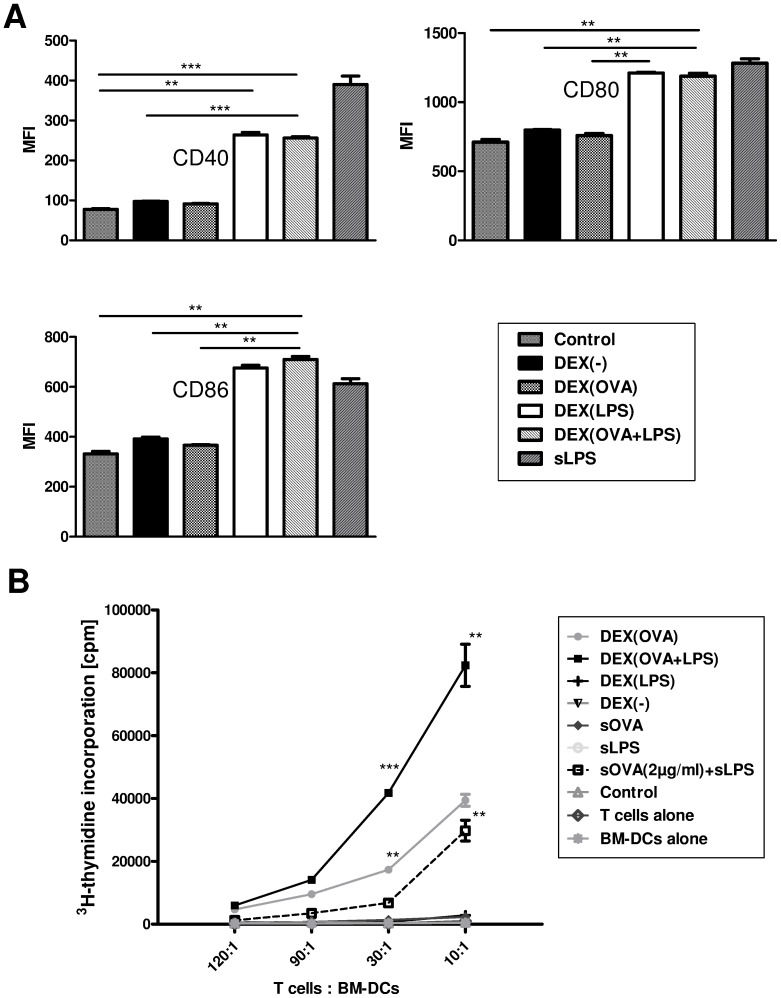
BM-DCs are strongly activated by LPS-containing DEX particle formulations, and codelivery of OVA results in robust antigen-specific CD4+ T cell activation.(A) Aliquots of unstimulated day 6 BM-DCs (106 cells; C57BL/6) were left untreated (−), stimulated with LPS (100 ng/ml), or were coincubated with DEX particles (100 µl) as indicated for 24 h. Afterwards, expression of CD40, CD80, and CD86 was assessed by flow cytometry. Graphs denote mean fluorescence intensities (MFI) ± SEM of three experiments. Statistical significant differences between groups are indicated (**p<0.01, ***p<0.001). (B) Unstimulated day 6 BM-DCs (106 cells; C57BL/6) were treated with soluble OVA (2 µg) or as described in A for 24 h. Titrated numbers of BM-DCs were cocultured with sorted CD4+ OT-II T cells in triplicates for 3 days at the ratios indicated. T cell proliferation was assessed as incorporation of 3H-thymidine added for the last 16–18 h. Data represent mean±SEM of triplicates and are representative of three independent experiments. Statistical significant differences between DEX(OVA-LPS) versus OVA plus LPS and DEX(OVA) versus OVA for each T cell/BM-DC ratio are indicated (*p<0.05, **p<0.01).